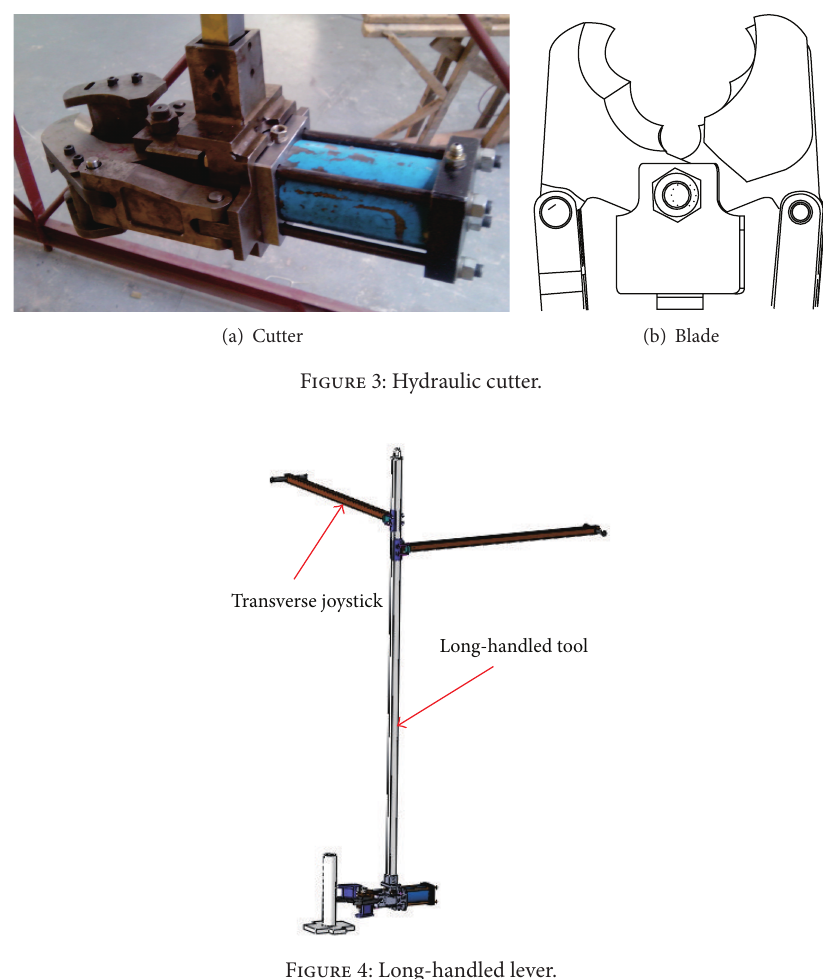
Figure 4: Long-handled